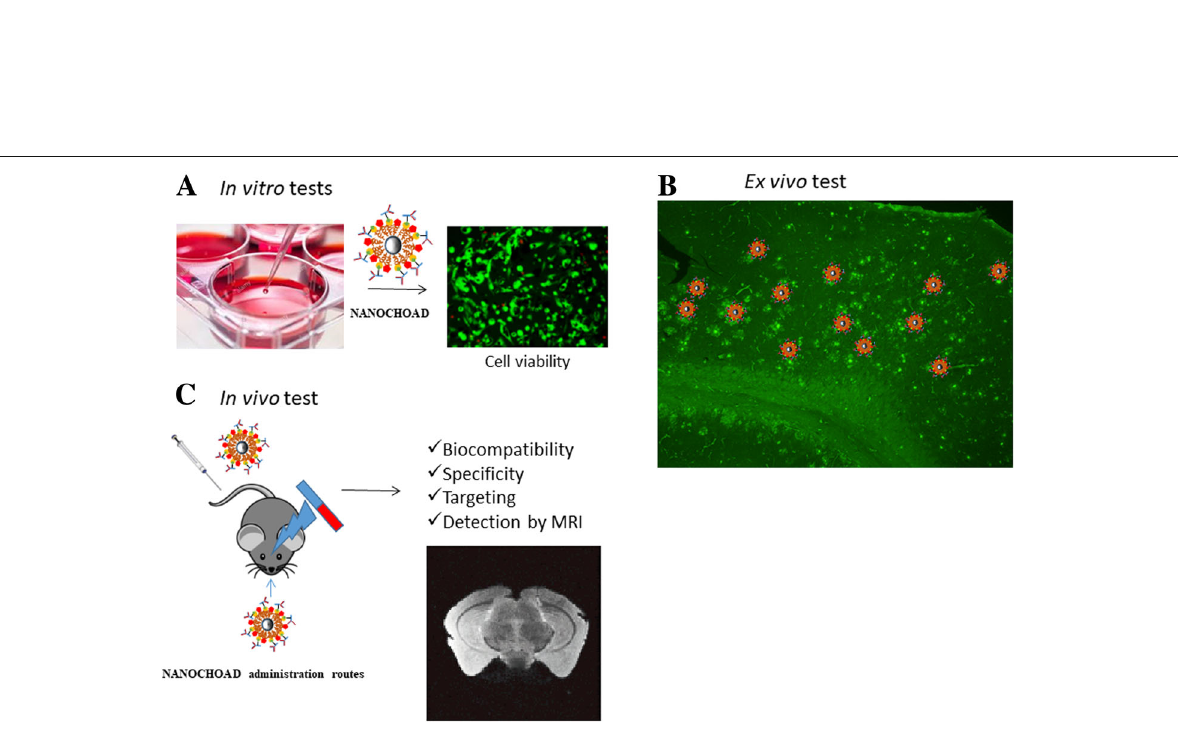
Fig. 2 Experimental design to test the hypothesis. First, in vitro ( a ): determination of the biocompatibility of the synthesized nanoconjugate. Ex vivo test ( b ): testing the specificity of anti-CHO-MNPs nanoconjugate by incubation of nanoplatform on fixed brain slices from 5XFAD transgenic mice. In vivo studies ( c ): the nanoplatform will be injected intravenously or by alternative routes as intranasal delivery/external magnetic field application, and its effectiveness (targeting) will be evaluated by